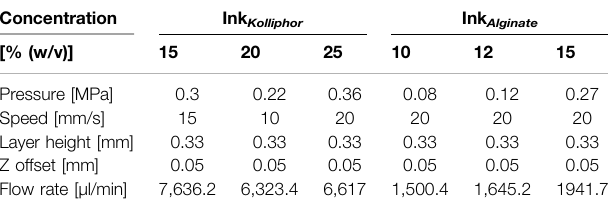
TABLE 5 | Printing parameters for the investigation of reproducibility. The set fl ow ratevaluesforthecFRcase(lastline)correspondtothesensordataandnotto the actual fl ow rates. The Z offset means the distance between nozzle and substrate when the fi rst layer is printed.